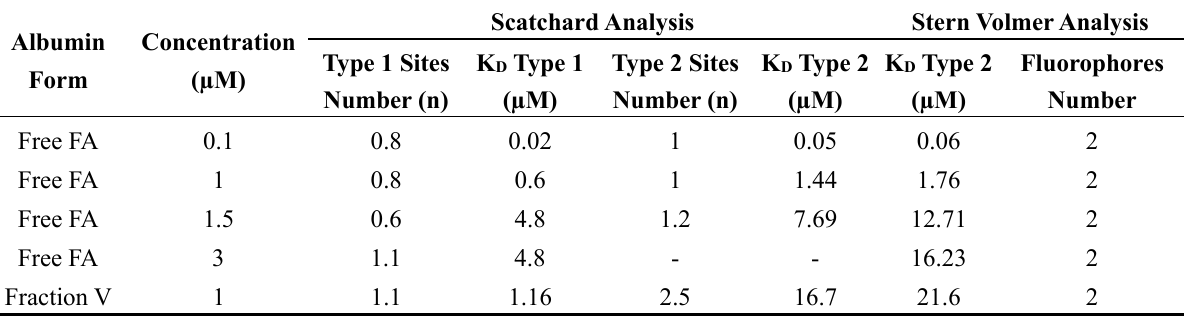
Table 1. Data for the resveratrol binding obtained by the attenuation